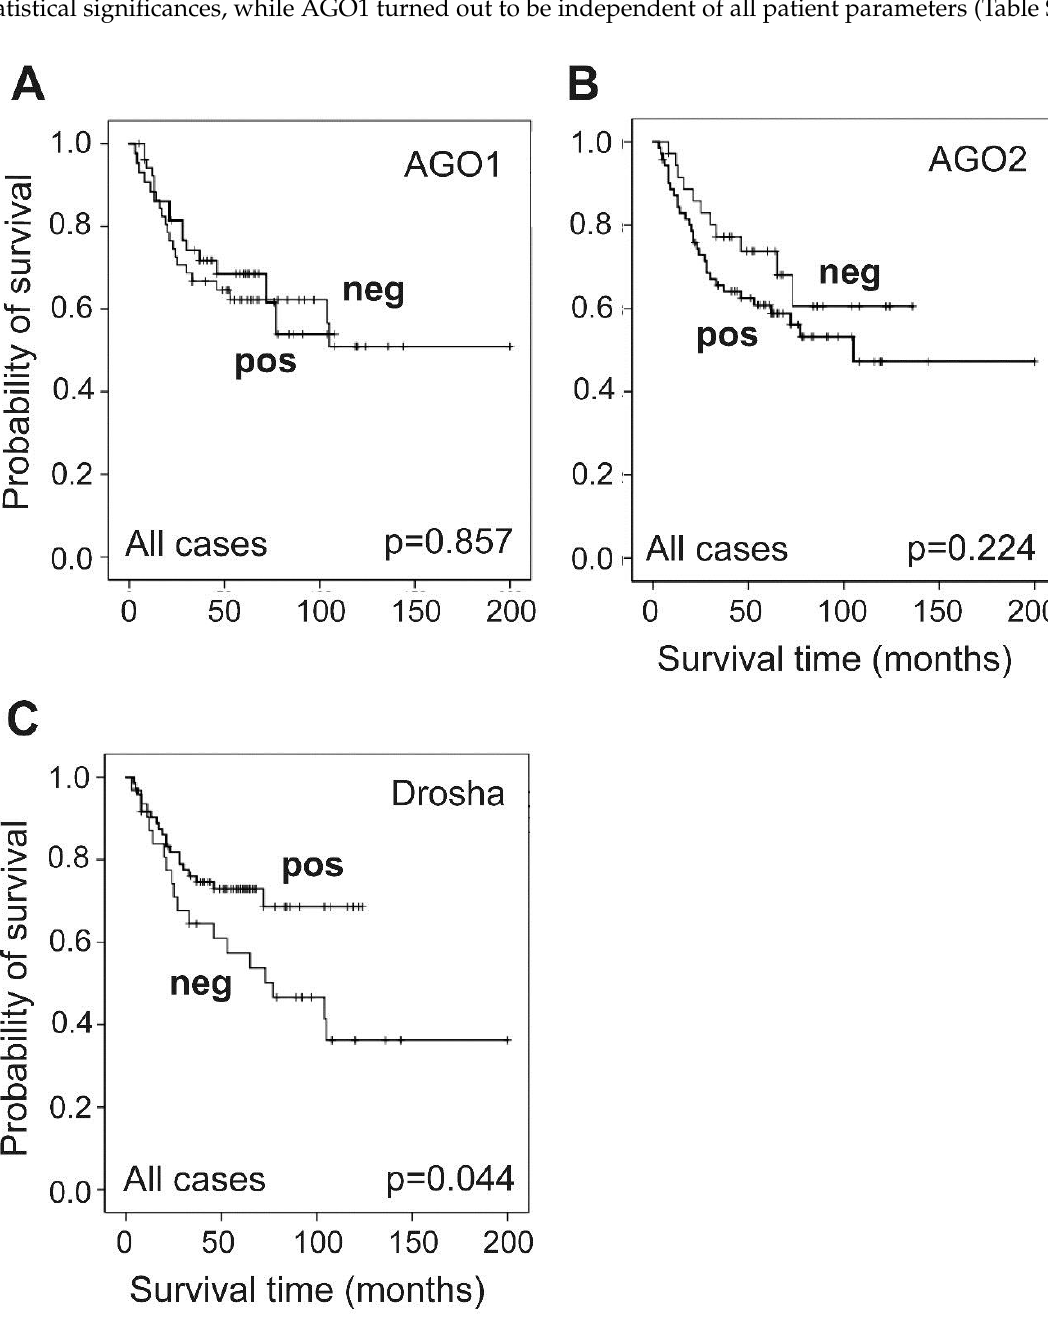
Figure 3. Kaplan–Meier analysis showing overall survival time of bladder cancer patients as a function of AGO1, AGO2 and Drosha levels. Dichotomized expression was not associated with overall survival for 96 cases of AGO1 ( A ) and 107 cases of AGO2 staining ( B ), but Drosha significantly indicated a higher probability of survival with positive expression regarding the 104 available cases ( C ). The overall survival time was defined as the months elapsed between transurethral resection or radical cystectomy and death or the last follow-up date. Censored cases were marked (+). Statistical significance was given as p < 0.05. Pos: positive, neg: negative.